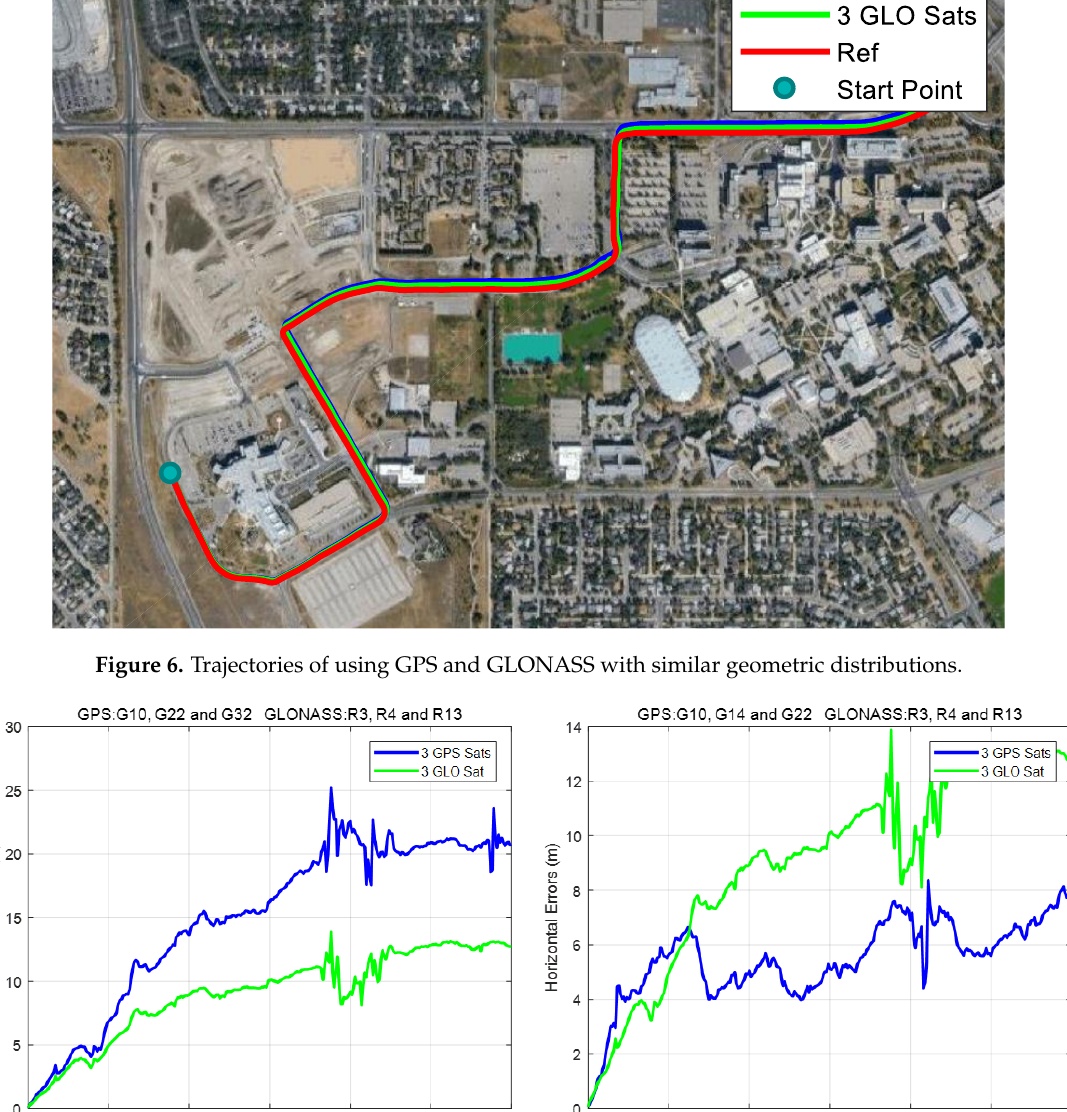
Figure 7. Horizontal errors with 3 GPS and 3 GLONASS satellites. ( a ) GPS satellites: G10, G22 and G32; ( b ) GPS satellites: G10, G14 and G22.